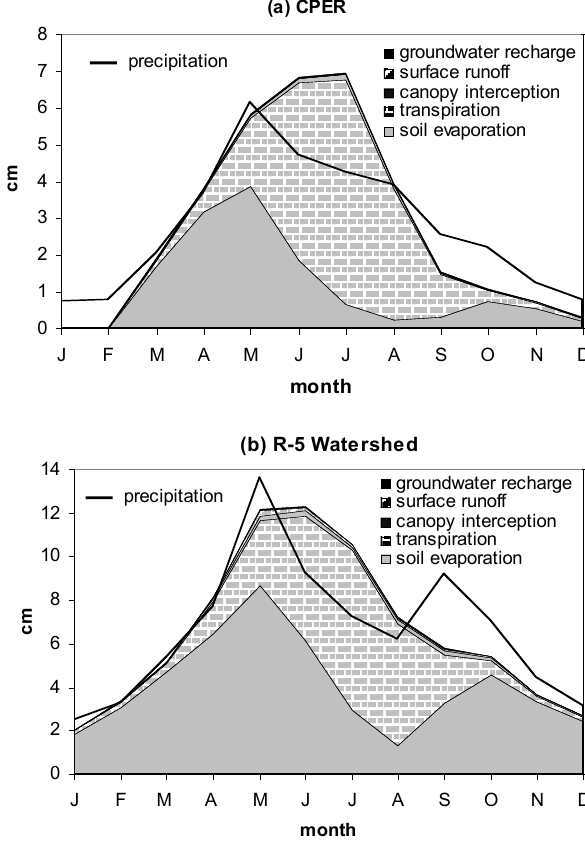
Fig. 10. Components of the modeled monthly mean water balance for: (a) the CPER silt-loam slope with a peak green LAI of 0.74, and (b) the R-5 watershed with a peak green LAI of 1.8. All losses are plotted on top of each other such that when their sum is greater than precipitation, soil and/or snow storages are being depleted, and when their sum is less than precipitation, the storages are being